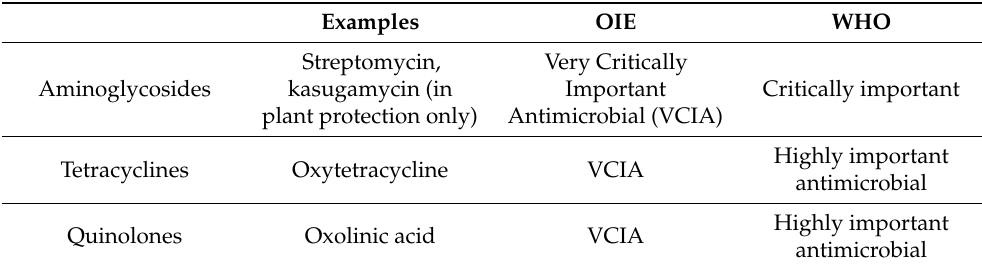
Table 2. Classification of importance of antimicrobials by the World Health Organization (WHO) and the World Organization for Animal Health (OIE). Examples OIE WHO Streptomycin, Very Critically Aminoglycosides kasugamycin (in Important plant protection only) Antimicrobial (VCIA)